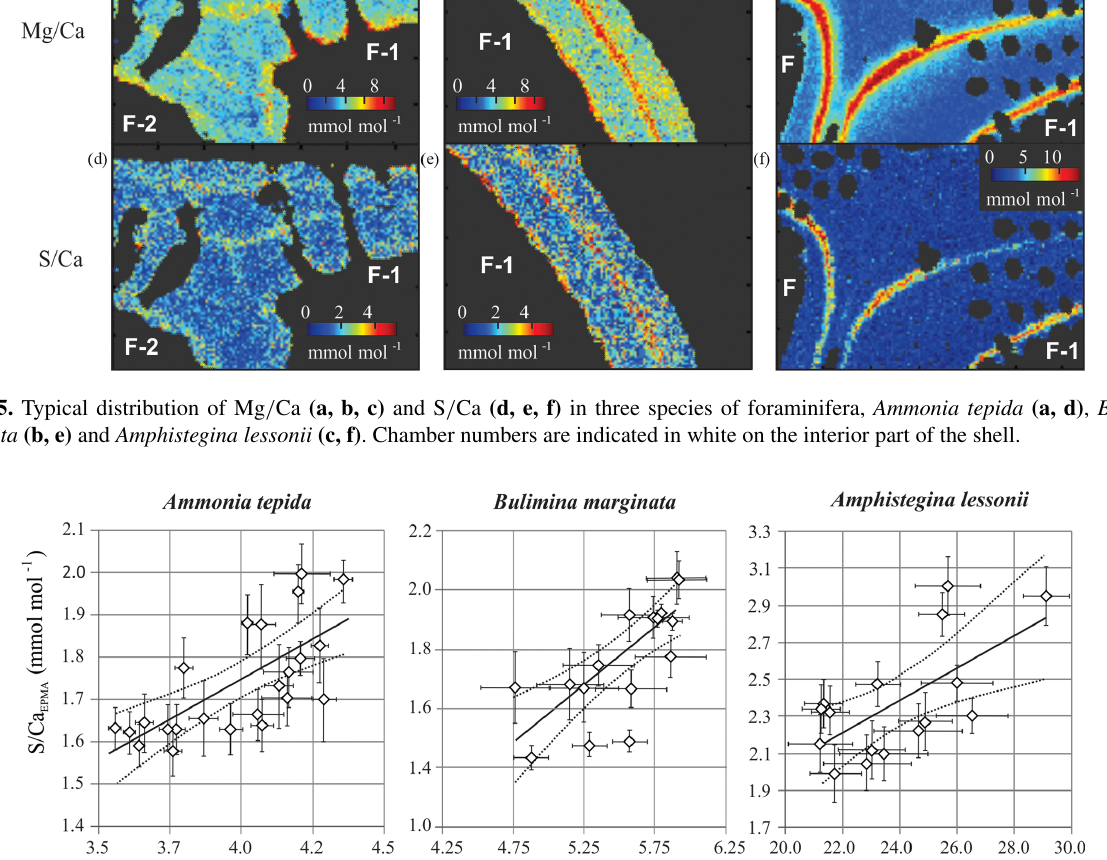
tory Mg / Ca–temperature calibration for Amphistegina